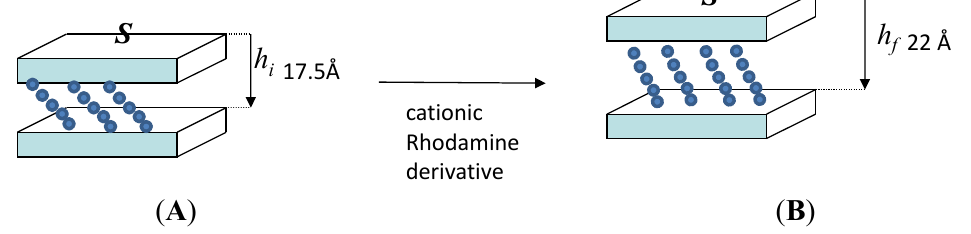
Figure 1. Possible arrangement of montmorillonite layers before ( A ) and after ( B ) the intercalation of rhodamine derivative. Reproduced from Esposito et al. [24].